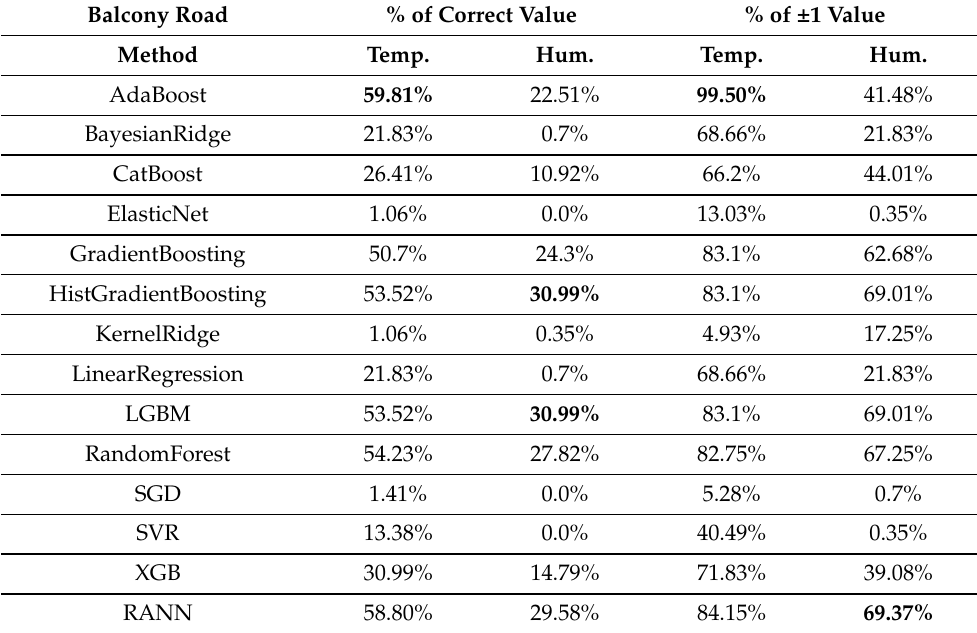
Table 2. Evaluation of algorithms for the measurements bedroom-road balcony.